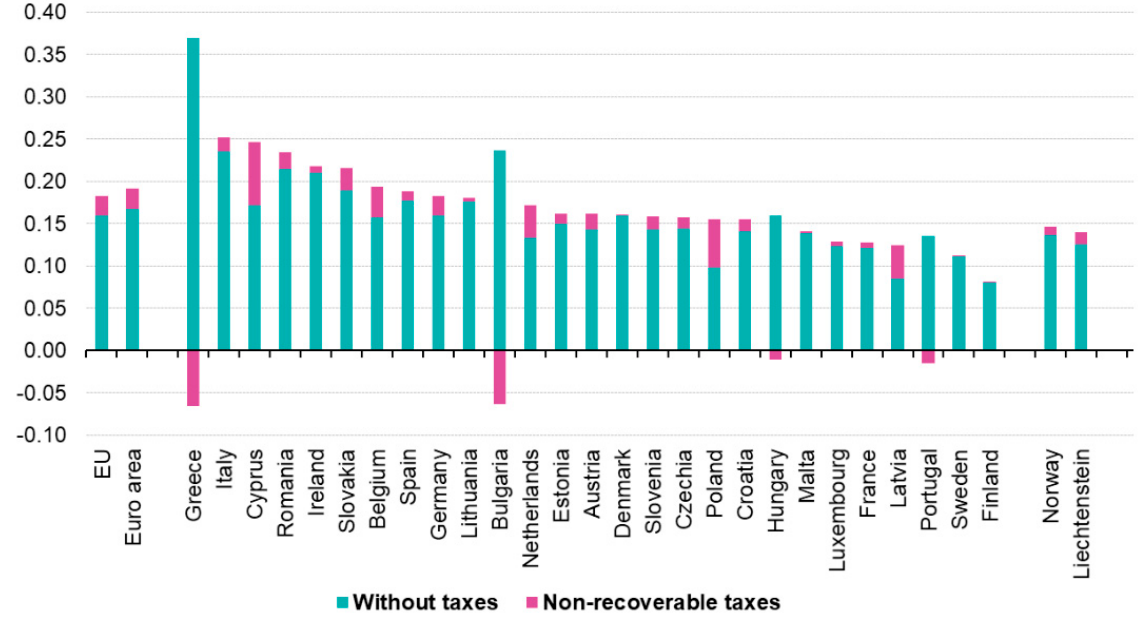
Figure 7. Electricity prices for non-household consumers in the Euro area for first half 2002 (in EUR per kWh). Source: Eurostat [91].